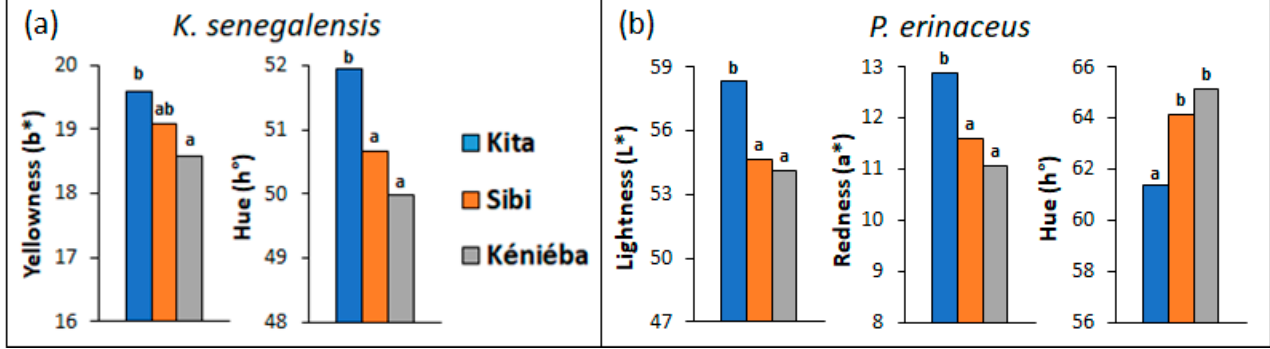
Figure 3. Bar chart of the mean values of color parameters showing significant differences between samples from the three areas; ( a ) for K. senegalensis ( n = 8 for Kita, n = 8 for Sibi and n = 8 for Kéniéba), ( b ) for P. erinaceus ( n = 6 for Kita, n = 5 for Sibi and n = 6 for Kéniéba); (the labels a, ab, and b refer to